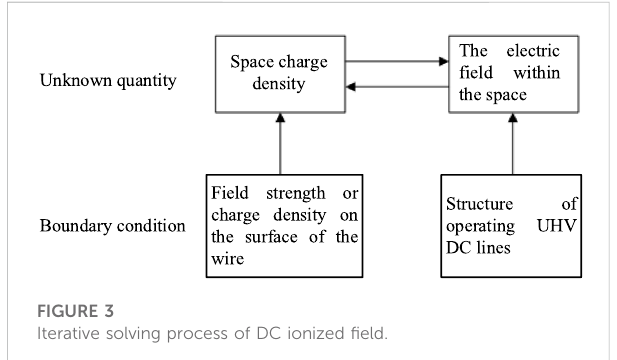
FIGURE 3 Iterative solving process of DC ionized fi eld.